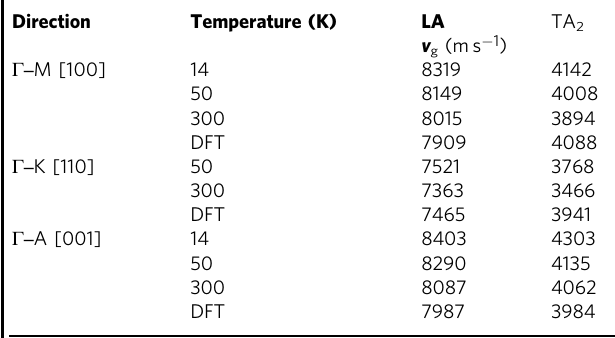
Relaxed fi rst principles (DFT) results are listed for